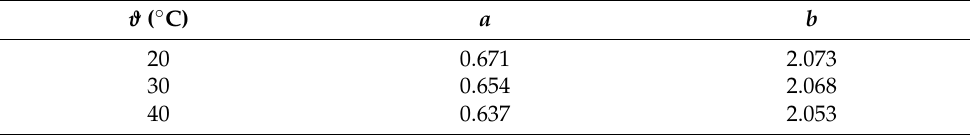
Table A1. Coefficients a and b for the three